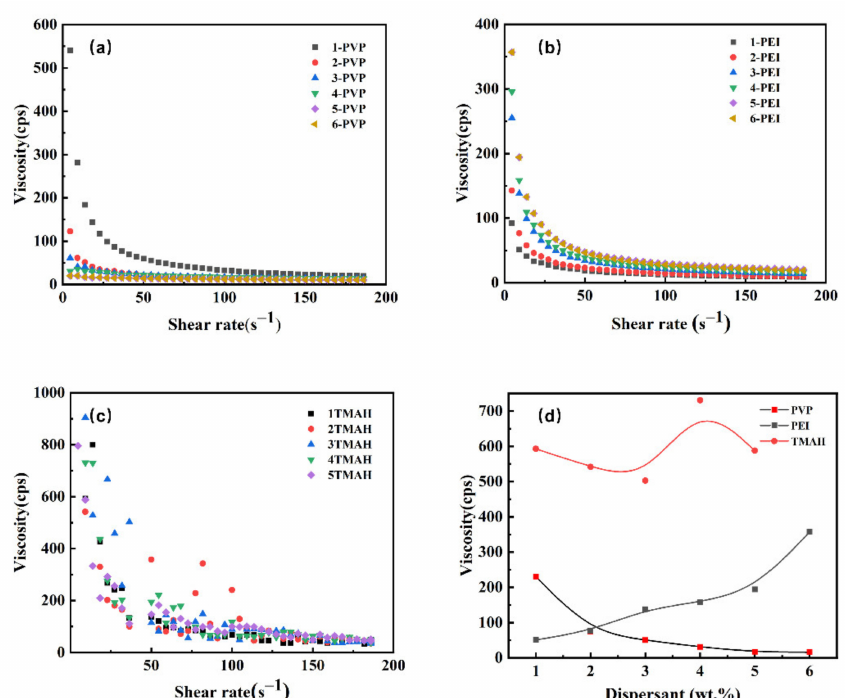
Figure 4. Viscosity as a function of the shear rate of SiC slurries with 20 vol.% solids loading under di ff erent concentrations of dispersants ( a – c ), and the viscosity of di ff erent dispersants at the determined shear rate with 10 s − 1 ( d